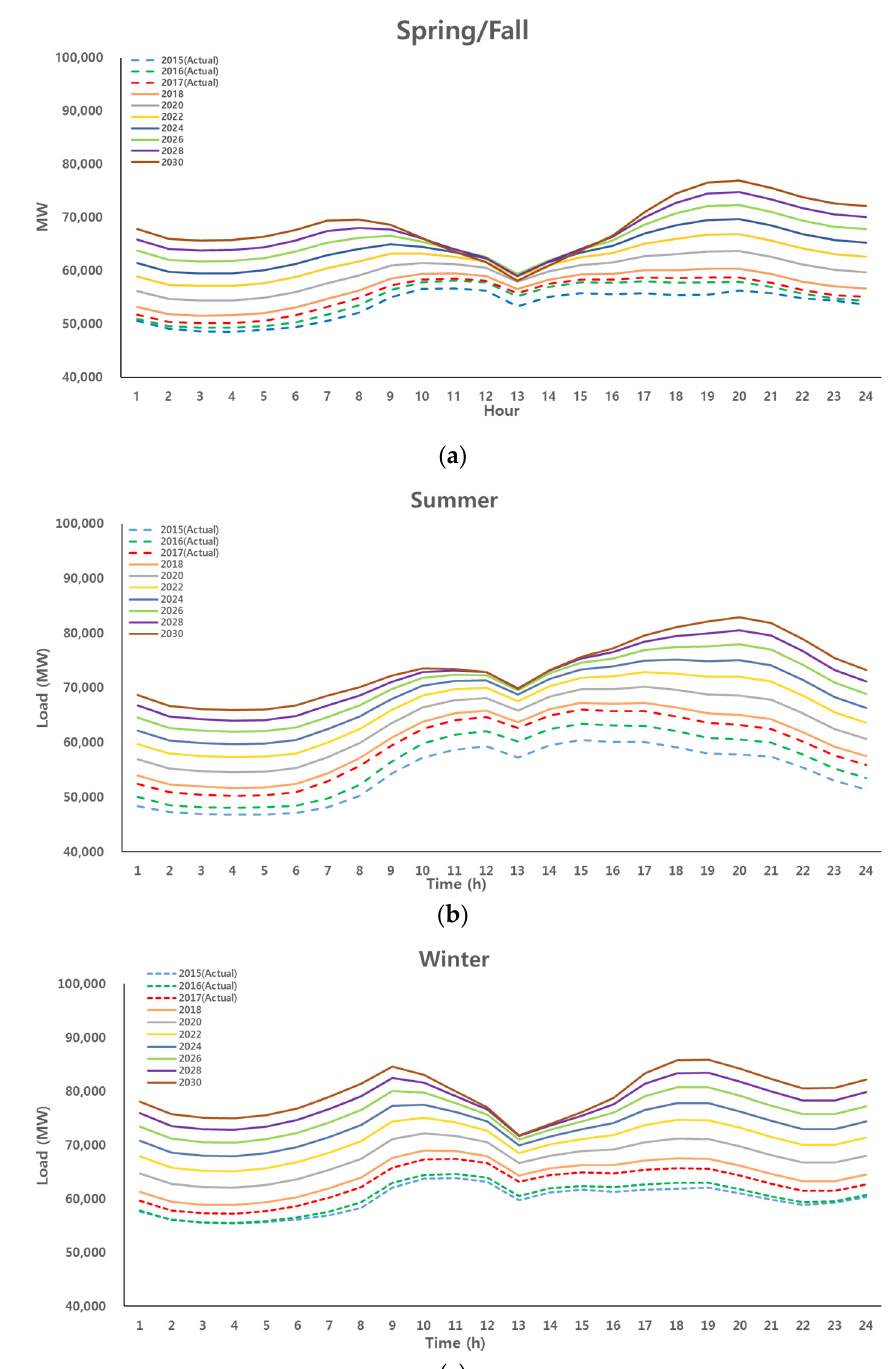
Figure 7. Seasonal predicted net load curves in each year from 2017 to 2030 considering only PV: ( a ) for spring and fall; ( b ) for summer; and ( c ) for winter. Table 10. The predicted net load from 2018 to 2030.